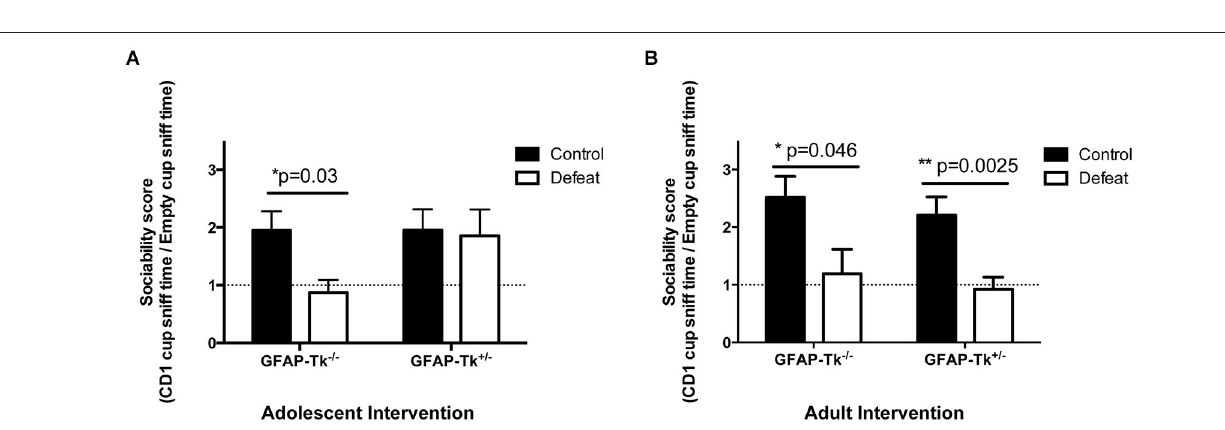
FIGURE 6 | Susceptibility to social defeat. (A) In the adolescent group GFAP-Tk − / − mice showed a reduced sociability score following social defeat compared to control (naïve) mice indicating susceptibility. The sociability scores of GFAP-Tk + / − mice following social defeat do not differ from GFAP-Tk + / − or GFAP-Tk − / − naïve mice indicating resilence. (B) In the adult group both GFAP-Tk − / − and GFAP-Tk + / − mice in the defeat condition